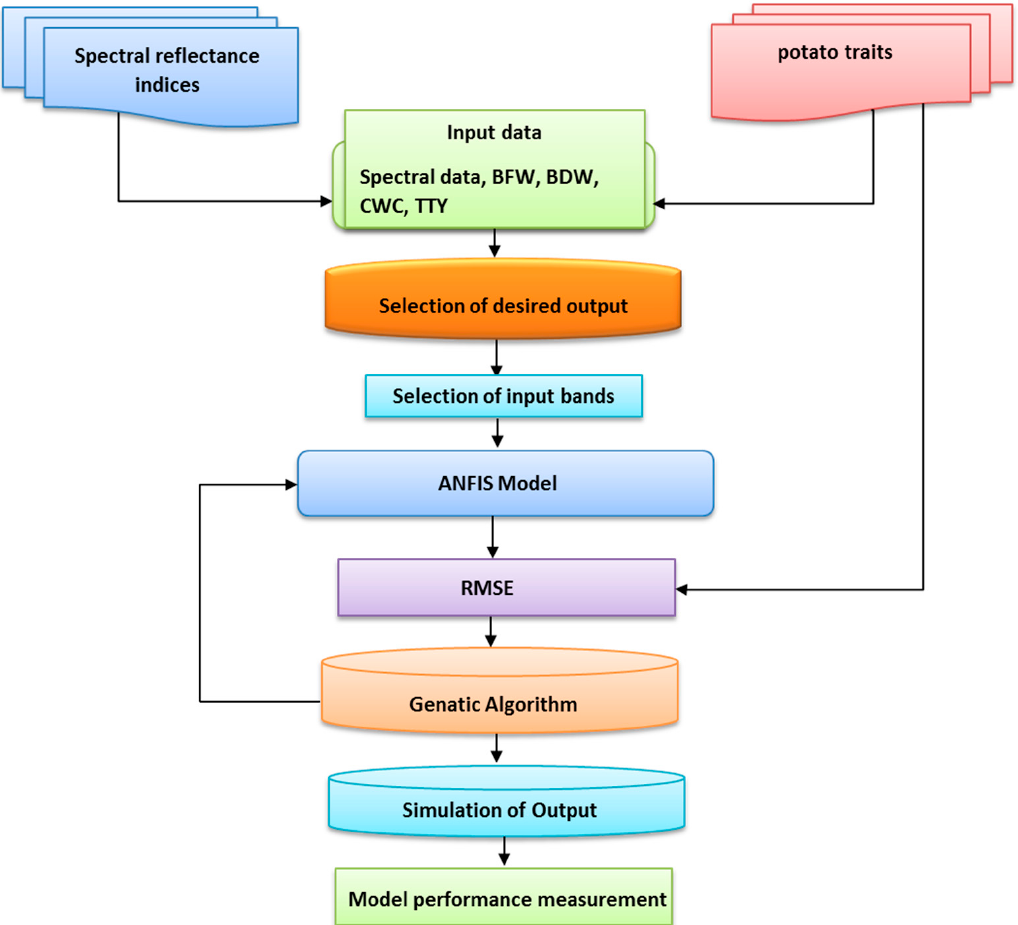
Figure 3. Schematic diagram of the adaptive neuro-fuzzy inference system (ANFIS) used in this study to predict the biomass fresh weight (BFW), biomass dry weight (BDW), canopy water content (CWC), and total tuber yield (TTY) of both potato varieties based on the selected spectral reflectance indices (SRIs). RMSE indicate root mean square error.